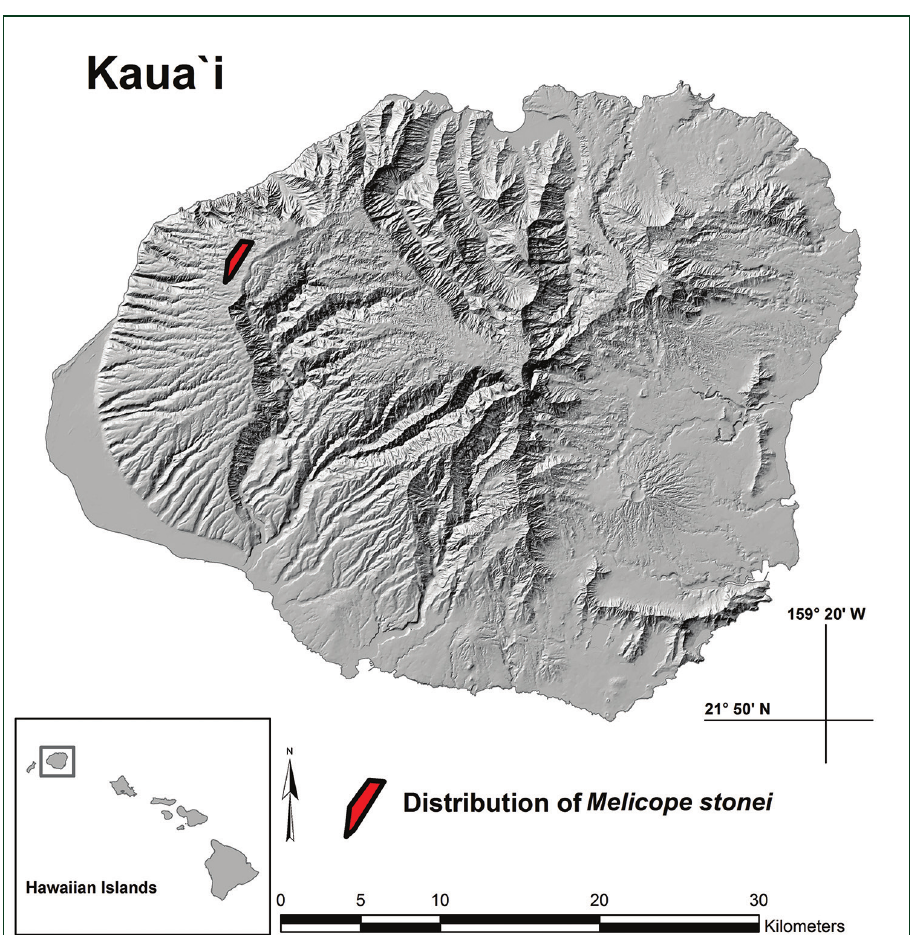
Figure 3. Map of Kaua‘i, Hawaiian Islands, with polygon indicating distribution of Melicope stonei in the Kōke‘e